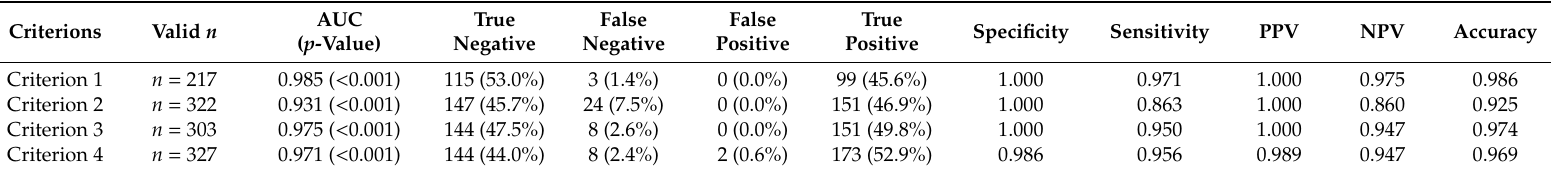
Table 2. Predictive power of the diagnostic test combinations.